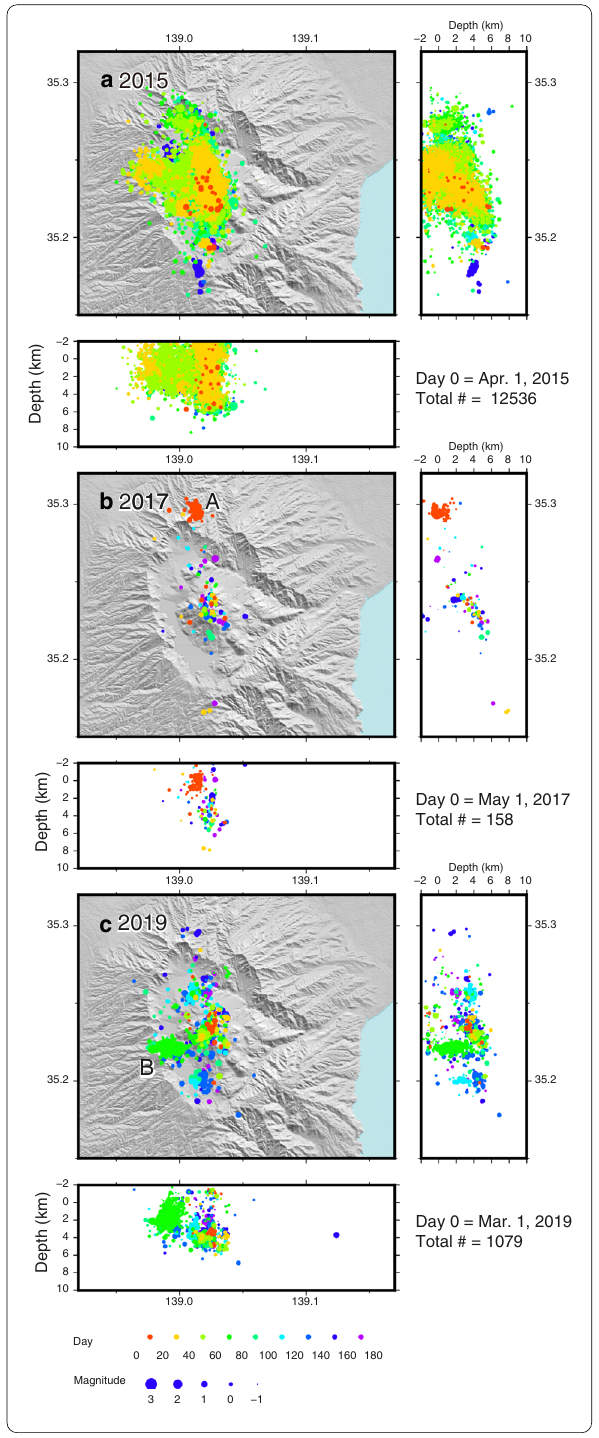
Fig. 4 Maps of hypocenters of volcano-tectonic earthquakes during the co-eruptive (2015) and post-eruptive (2017 and 2019) volcanic unrest episodes. Day 0 is set to the first day of a month during which onset of the edifice inflation was observed and shown in the bottom-right corner of each panel. Hypocenters of earthquakes that occurred within 180 days after day 0 are plotted. Colors indicate days after day 0 and the radius of each circle indicates magnitude of the earthquake. The total number of earthquakes during the 180 days are shown in the bottom-right corner of each panel. A in b) indicates the earthquake swarm in early May in 2017. B in c) indicates the swarms on 18 and 19 of May in 2019